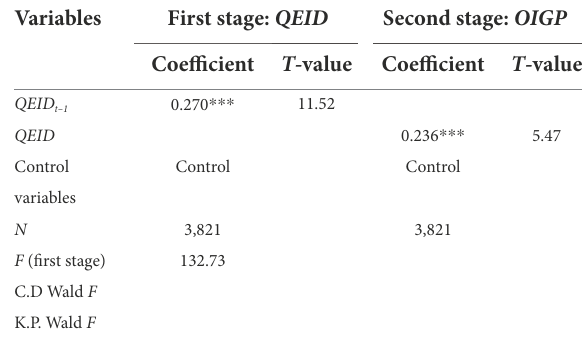
TABLE 13 Results of